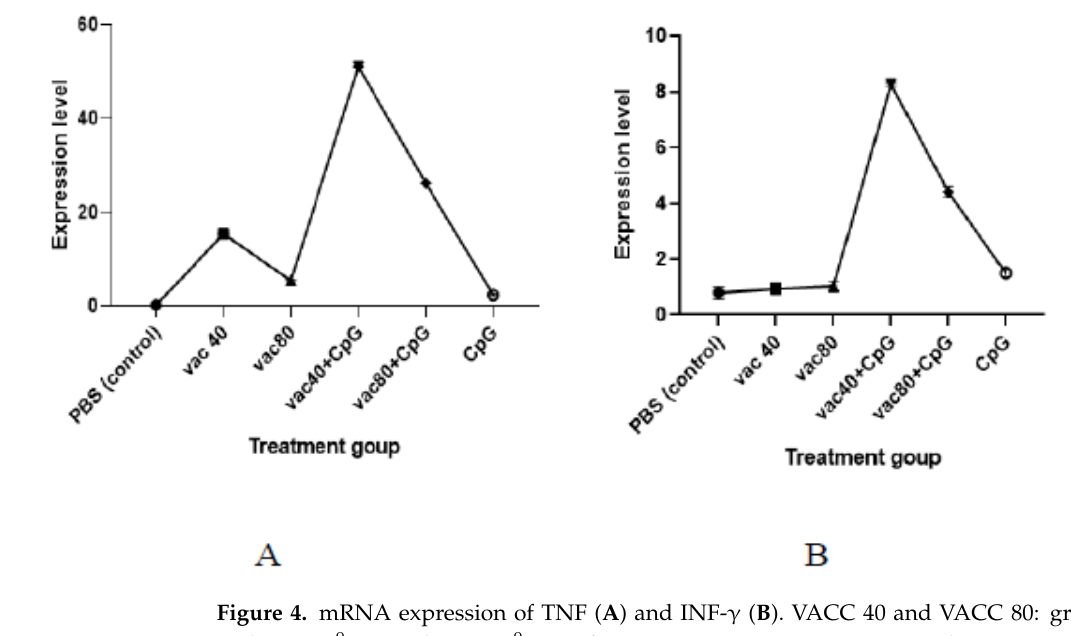
Figure 4. mRNA expression of TNF ( A ) and INF- γ ( B ). VACC 40 and VACC 80: groups treated with 4 × 10 9 VP and 8 × 10 9 VP of vaccine concentration, respectively, VACC 40 +CpG and VACC 80 + CpG: groups treated with 4 × 10 9 VP and 8 × 10 9 VP of vaccine plus CpG ODNs, CpG: group treated with CpG ODNs, and PBS: group treated with PBS. Table 6. Results from Hematological